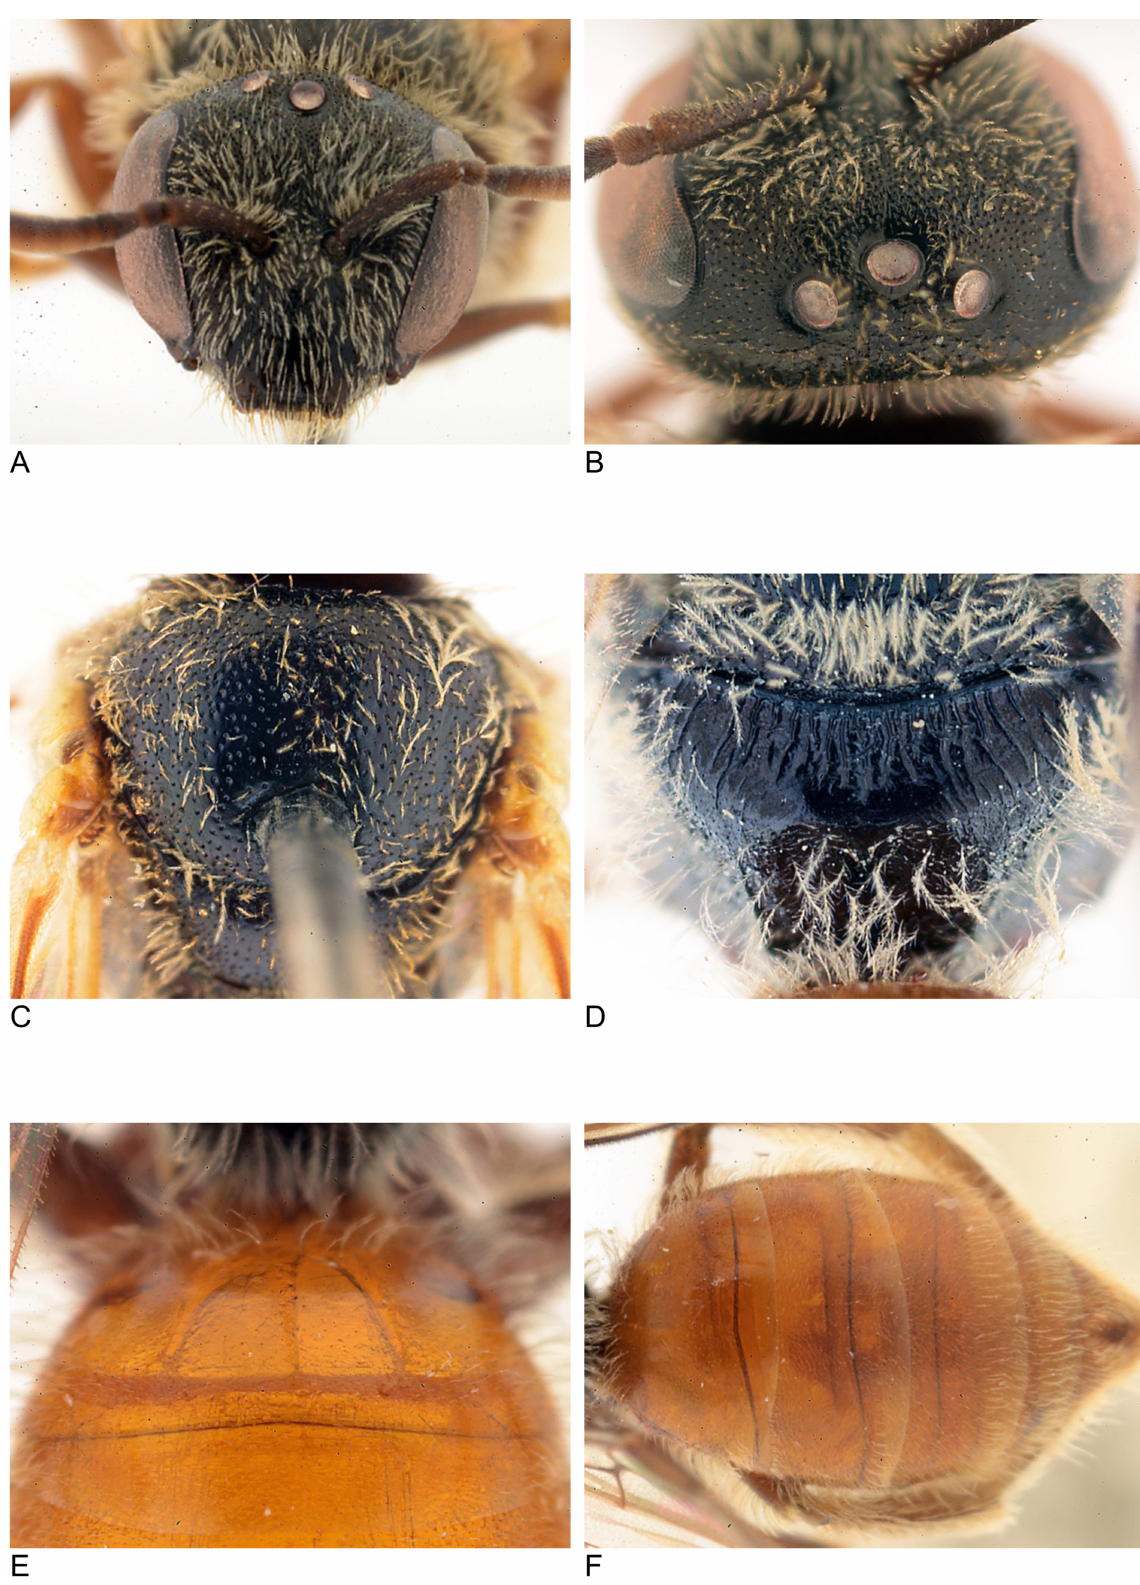
Fig. 13. Lasioglossum villosulum arabicum Ebmer, 2008, ♀ (UAE). A . Head. B . Punctation around ocellus. C . Scutum. D . Propodeum. E . First tergum. F